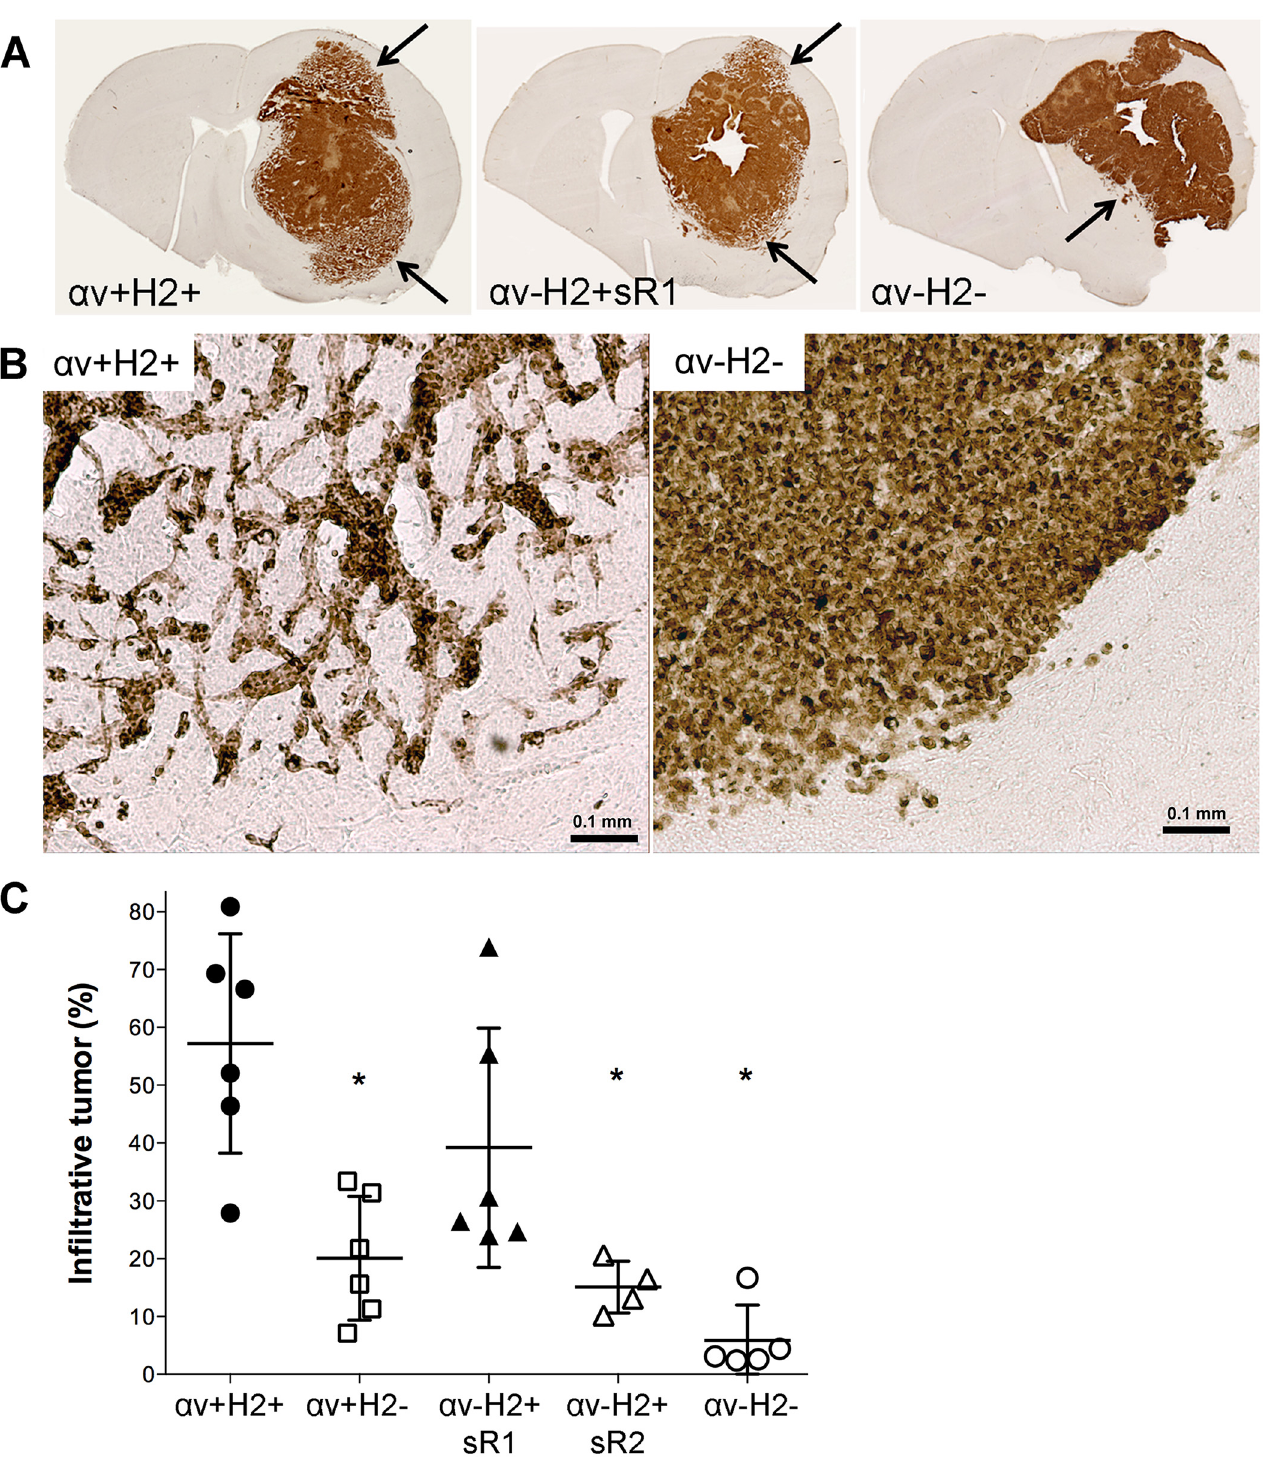
Fig 6. In vivo invasive growth phenotype in α v-integrin and HER2 knockdown breast cancer cells. Brain tumors of MM2BH clones were assessed by immunohistochemistry for human mitochondrial antigen 5-weeks after intracerebral implantation. (A) Representative sections from α v+H2+, α v-H2+sR1, and α v-H2- tumors. Arrows indicate regions of tumor infiltration. (B) Brain tumor margin showing the infiltrative phenotype in α v+H2+ and α v-H2- tumors. (C) Quantification of the percent of tumor showing the infiltrative phenotype in each tumor type. Each point indicates the mean value from 2 – 6 central sections from each rat brain. * p < 0.05 compared to